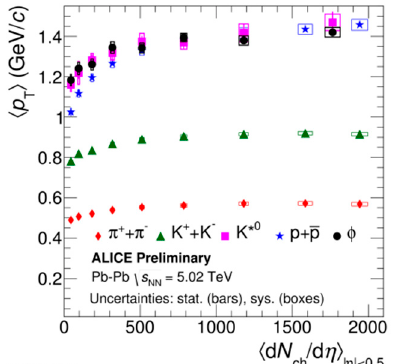
Figure 4. Mean transverse momentum of K*(892) 0 and φ (1020) compared to that identified as π ± , K ± and p as a function of the mean charged-particle multiplicity density in Pb-Pb collisions at √𝒔 𝐍𝐍 = 5.02 TeV. Statistical uncertainties are represented as bars, whereas boxes indicate systematic uncertainties.